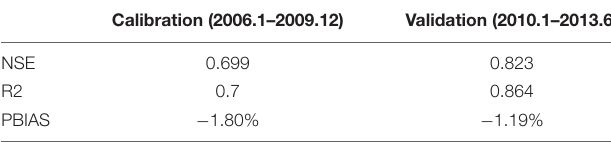
TABLE 3 | Results of the model verification indices.